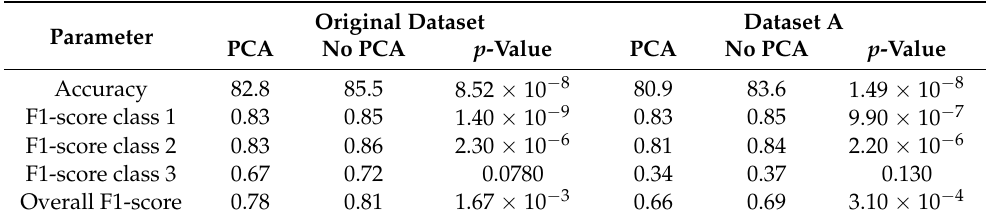
Table 5. Overview of the results for the 1 s time window for the original dataset and dataset A. Here, a comparison was made between applying Principal Component Analysis (PCA) or not applying Principal Component Analysis (No PCA). The p -value is provided to indicate whether the two values are significantly different ( p -value < α , p -value < 0.05) or not. Significance was tested with a paired samples t -test with a two-tailed distribution.